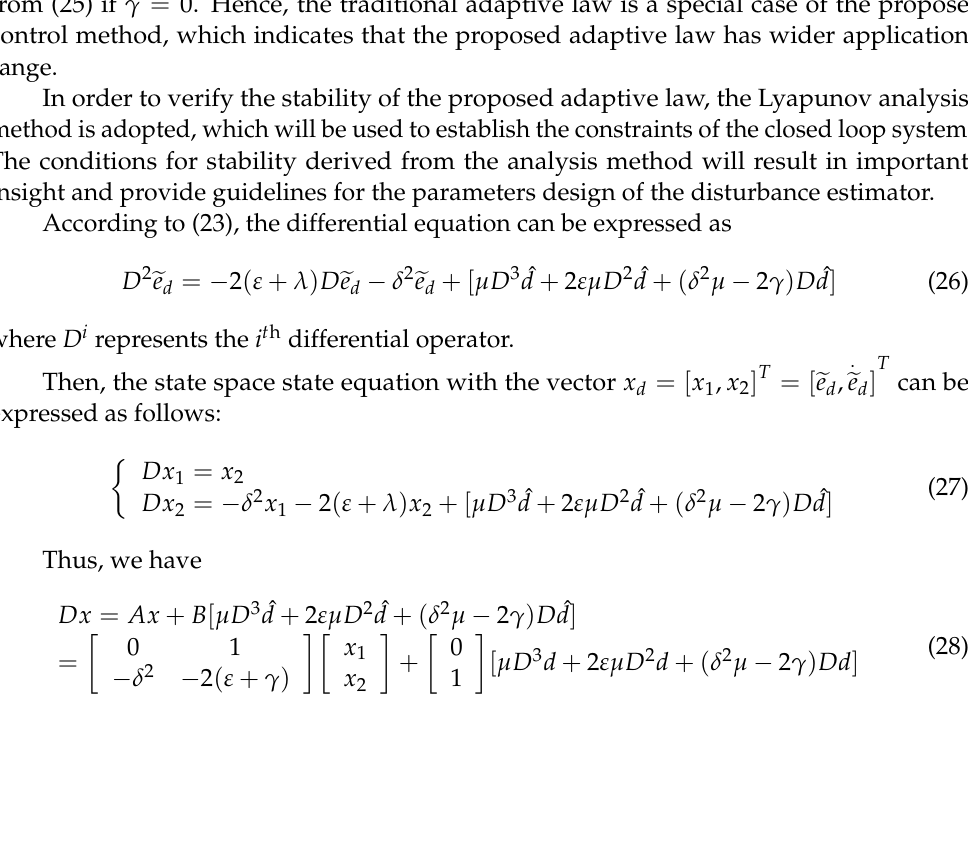
( ) G s m . Figure 3. Bode diagram of G m ( s )